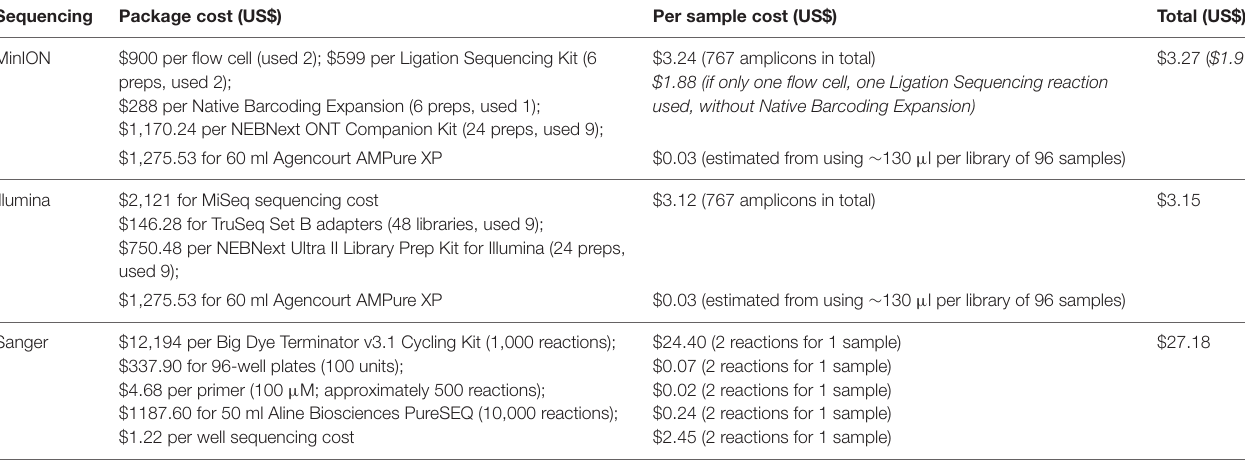
TABLE 4 | Cost comparison between MinION, Illumina and Sanger sequencing for this study.